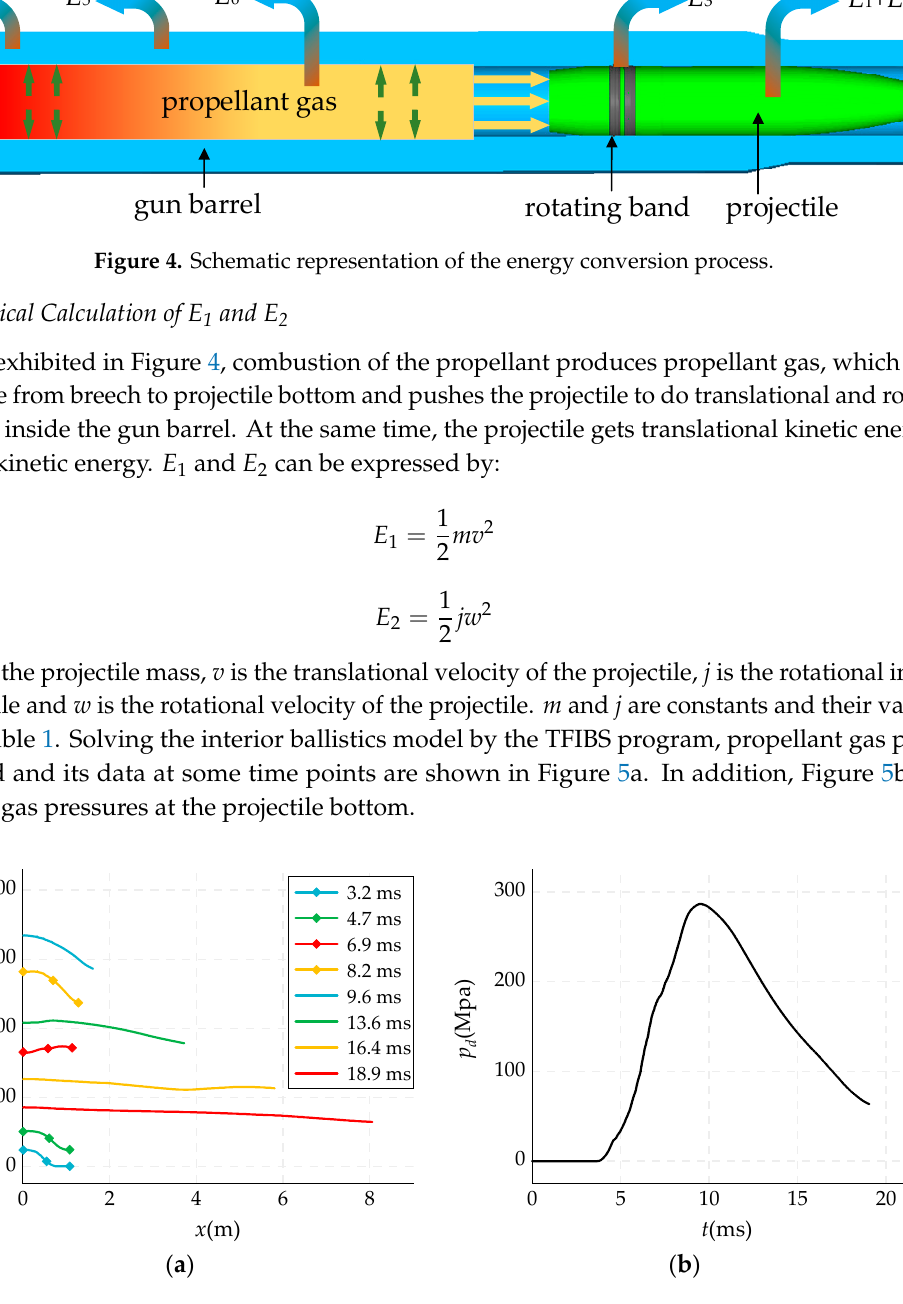
Figure 5. ( a ) Distribution of propellant gas pressure; ( b ) projectile bottom pressure.